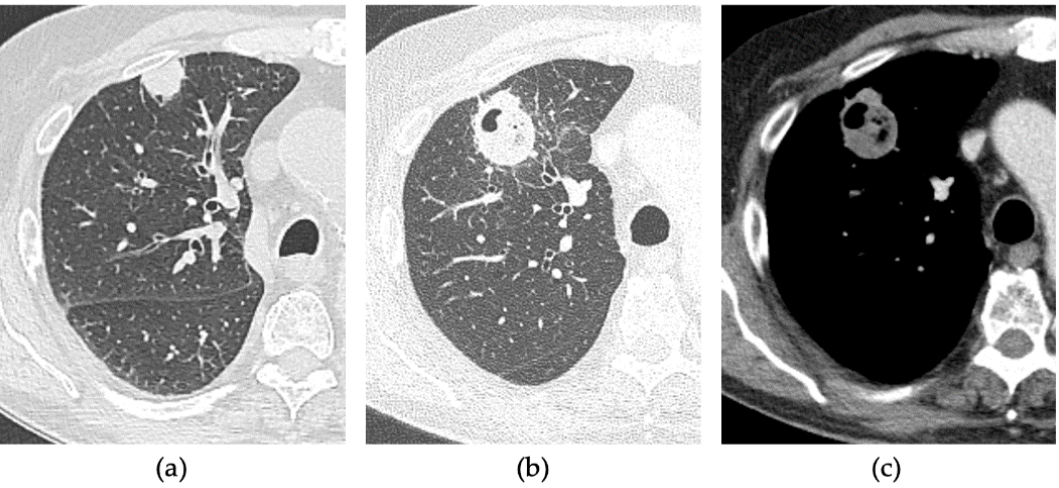
Figure 5. 83-years-old man with NSCLC in the right upper lobe. ( a ) Axial pre-treatment CT. Axial 1-month follow-up CECT after MWA with VPS shows ( b ) a nodular-shaped margin of the consolidation of the ablation zone and ( c ) with the uptake of contrast, suggestive of residual disease.